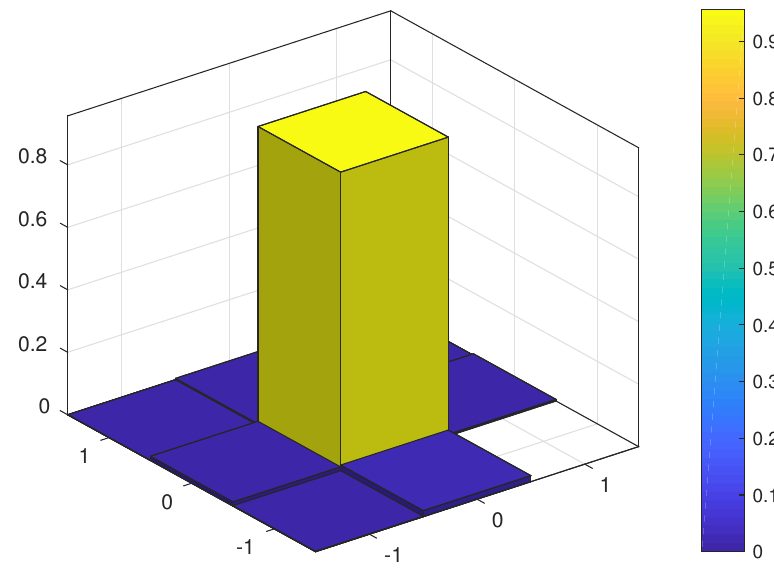
Figure 5. PMF of the TO estimation error for JMoM at E b / N 0 = 10